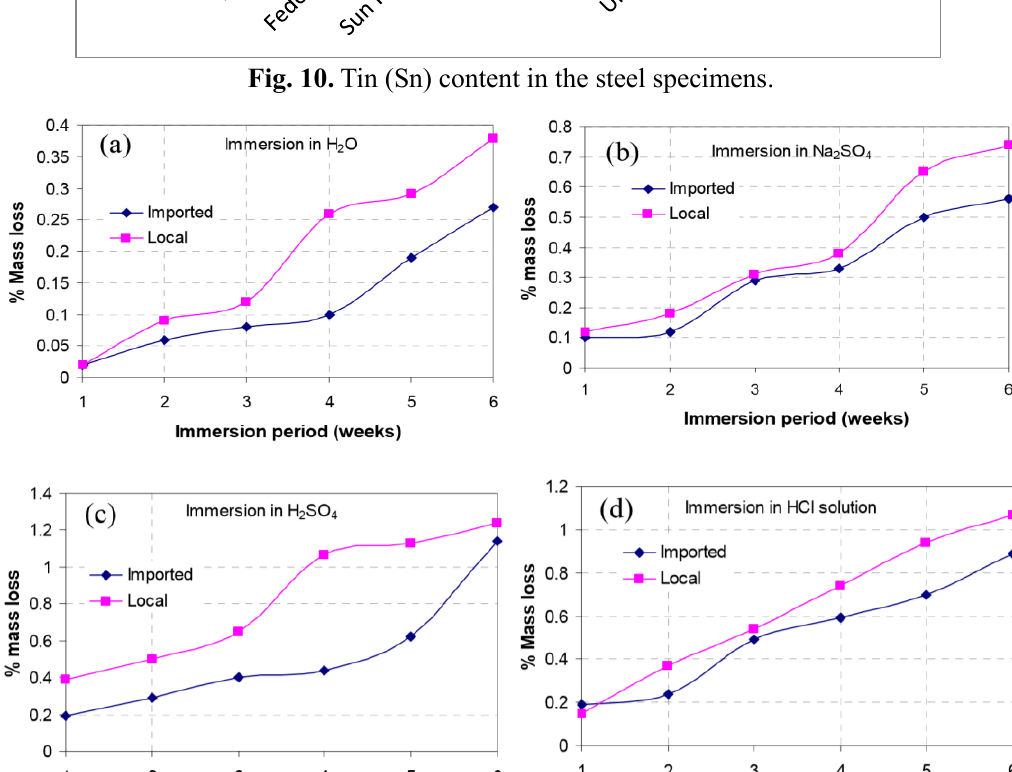
Fig. 11. Loss in mass of local and foreign steel reinforcements in different